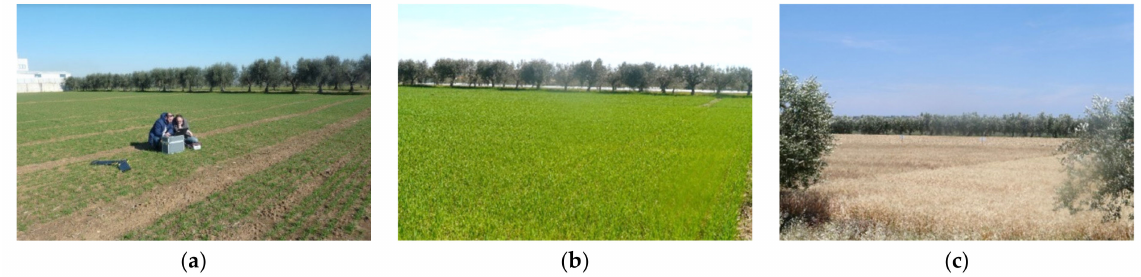
Figure 2. Pictures of the experimental field at seedling ( a ), tillering, ( b ) and harvest ( c